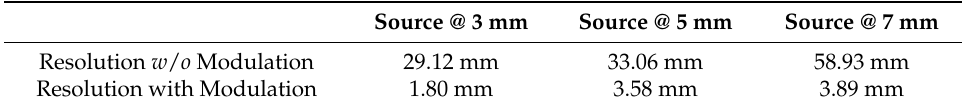
Figure 7. Surface thermal response to an AC stimulated sources at different depths. Presented are the different depths and frequency combinations for the DC and AC components. A cross-section (marked in dashed white line) through both components is also plotted. (( a – c ): 3 mm and 0.1 Hz; ( d – f ): 5 mm and 0.04 Hz; ( g – i ): 7 mm and 0.033 Hz). Table 2. Transverse resolution in different